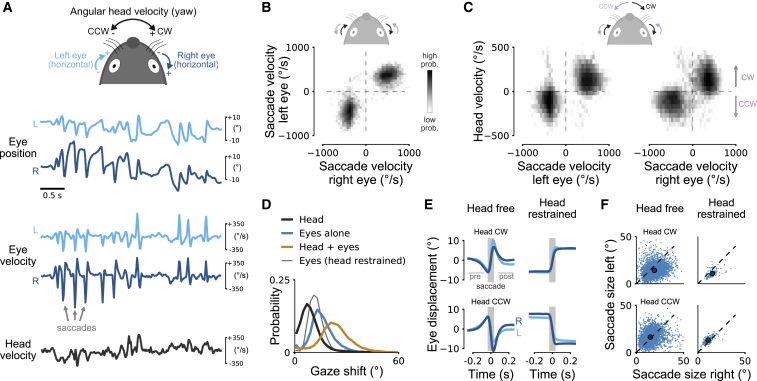
Rapid Saccadic Conjugate Horizontal Eye Movements in Freely Moving Mice(A) Schema for representing horizontal head and eye rotation axes (top). Examples of eye position (top traces), angular eye velocity (middle), and angular head velocity (bottom) in a freely moving mouse. High-velocity peaks during saccades coordinated between the two eyes are visible. Left eye is in light blue; right eye is in dark blue. Positive and negative head velocity indicates clockwise (CW) and counterclockwise (CCW) head rotation, respectively.(B) Log-scaled joint distribution of horizontal saccade velocity for the left and right eyes. 94% of saccades had the same sign for both eyes (10,331 saccades detected in both eyes).(C) Log-scaled joint distribution of horizontal saccade velocity for the left and right eyes and angular head velocity. Most saccades occurred during head rotations with eye rotations in the same direction as the head; same data as in Figure 1B.(D) Gaze shift magnitudes during saccades in freely moving mice: eyes and head together in orange, eyes alone in blue, head alone in dark gray, and, for comparison, gaze shift in head-restrained mice in thin gray line.(E) Average saccade profiles in freely moving (left) and head-restrained (right) mice. Saccades for CW (top) and CCW (bottom) head rotations (shaded gray area) were preceded and followed by a counter eye movement (“pre” and “post”) in freely moving mice, but not in head-restrained mice. Means ± SEM (smaller than line width).(F) Saccade sizes for CW and CCW head rotations in head-free (left) mice. On average, saccades were larger for temporal-to-nasal than for nasal-to-temporal saccades. Dots indicate average saccade sizes. Saccades in head-restrained mice for comparison (right) with same asymmetry in average saccade sizes as in head-free mice.See also Figure S2.